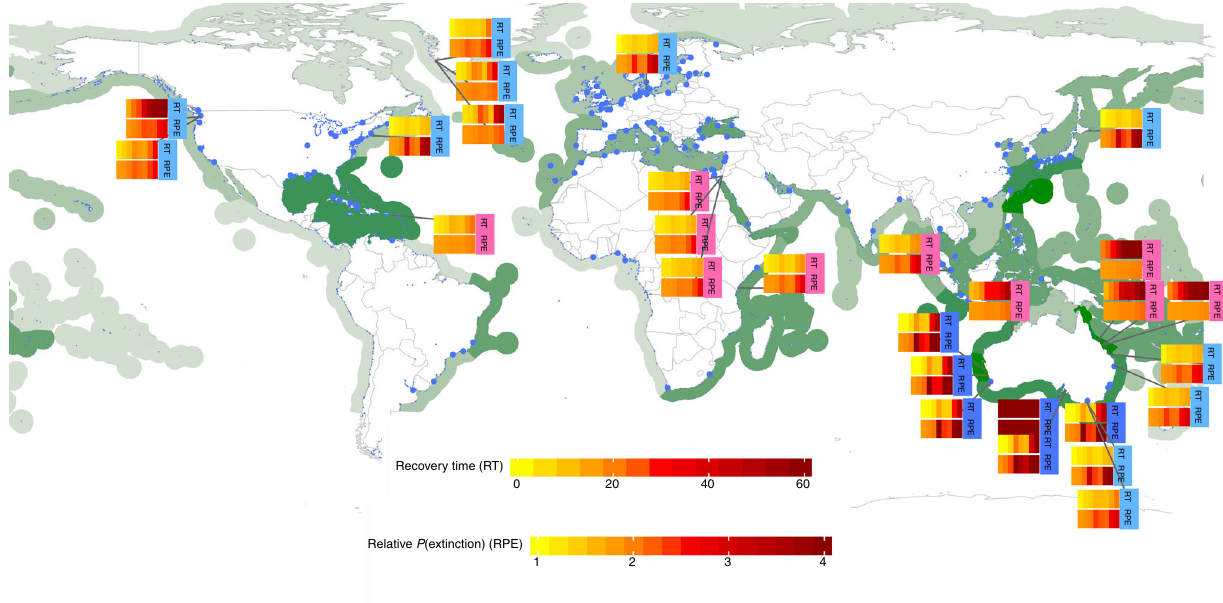
Fig. 2 Global distribution of seagrasses and ports showing resilience to dredging. Seagrass density 28 is shaded green and ports 29 are indicated by blue dots, where larger dots indicate larger harbours (generated using R software 30 and maps package). For 28 seagrass sites in the vicinity of ports and dredging, one-dimensional heat maps are shown of average recovery time (RT; top panels) and average relative probability of extinction (RPE; bottom panels). Each heat map has eight vertical bars, corresponding to dredging periods denoted as < dredge duration > − < alternating dredge/rest duration > of 1 – 0, 2 – 0, 3 – 0, 6 – 0, 6 – 3, 6 – 2, 9 – 0 and 12 – 0 months. Heat map labels are coloured by genus — pink for colonising Halophila light blue for opportunistic Zostera , and dark blue for persistent